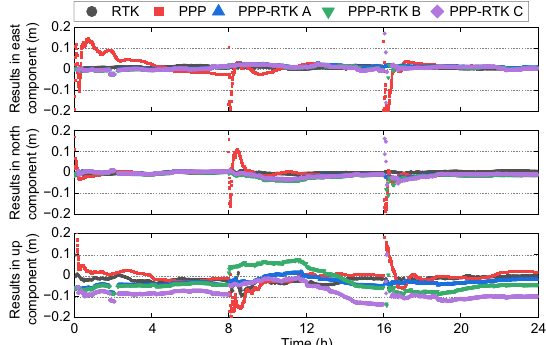
Fig. 2 Positioning errors in ENU components for the three